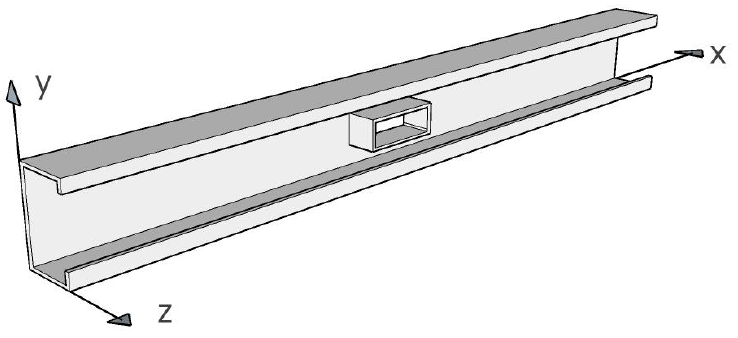
Figure 3. Three-dimensional perspective of a channel section with only one stiffened hole .